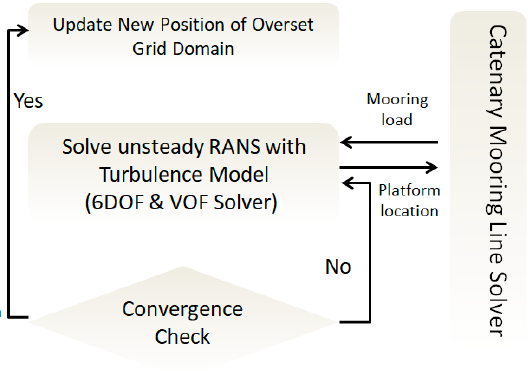
Figure 3. Flowchart of Dynamic Fluid Body Interaction (DFBI) method.